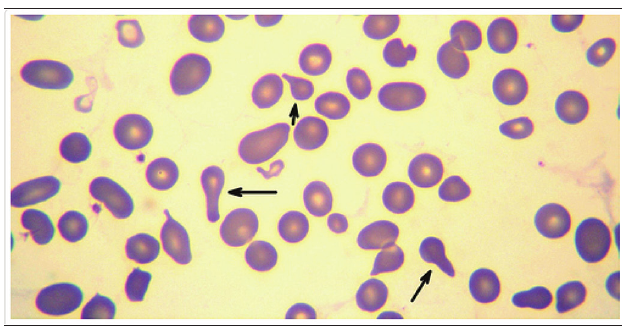
figurE 2 − Peripheral blood smear showing presence of dacrocytes